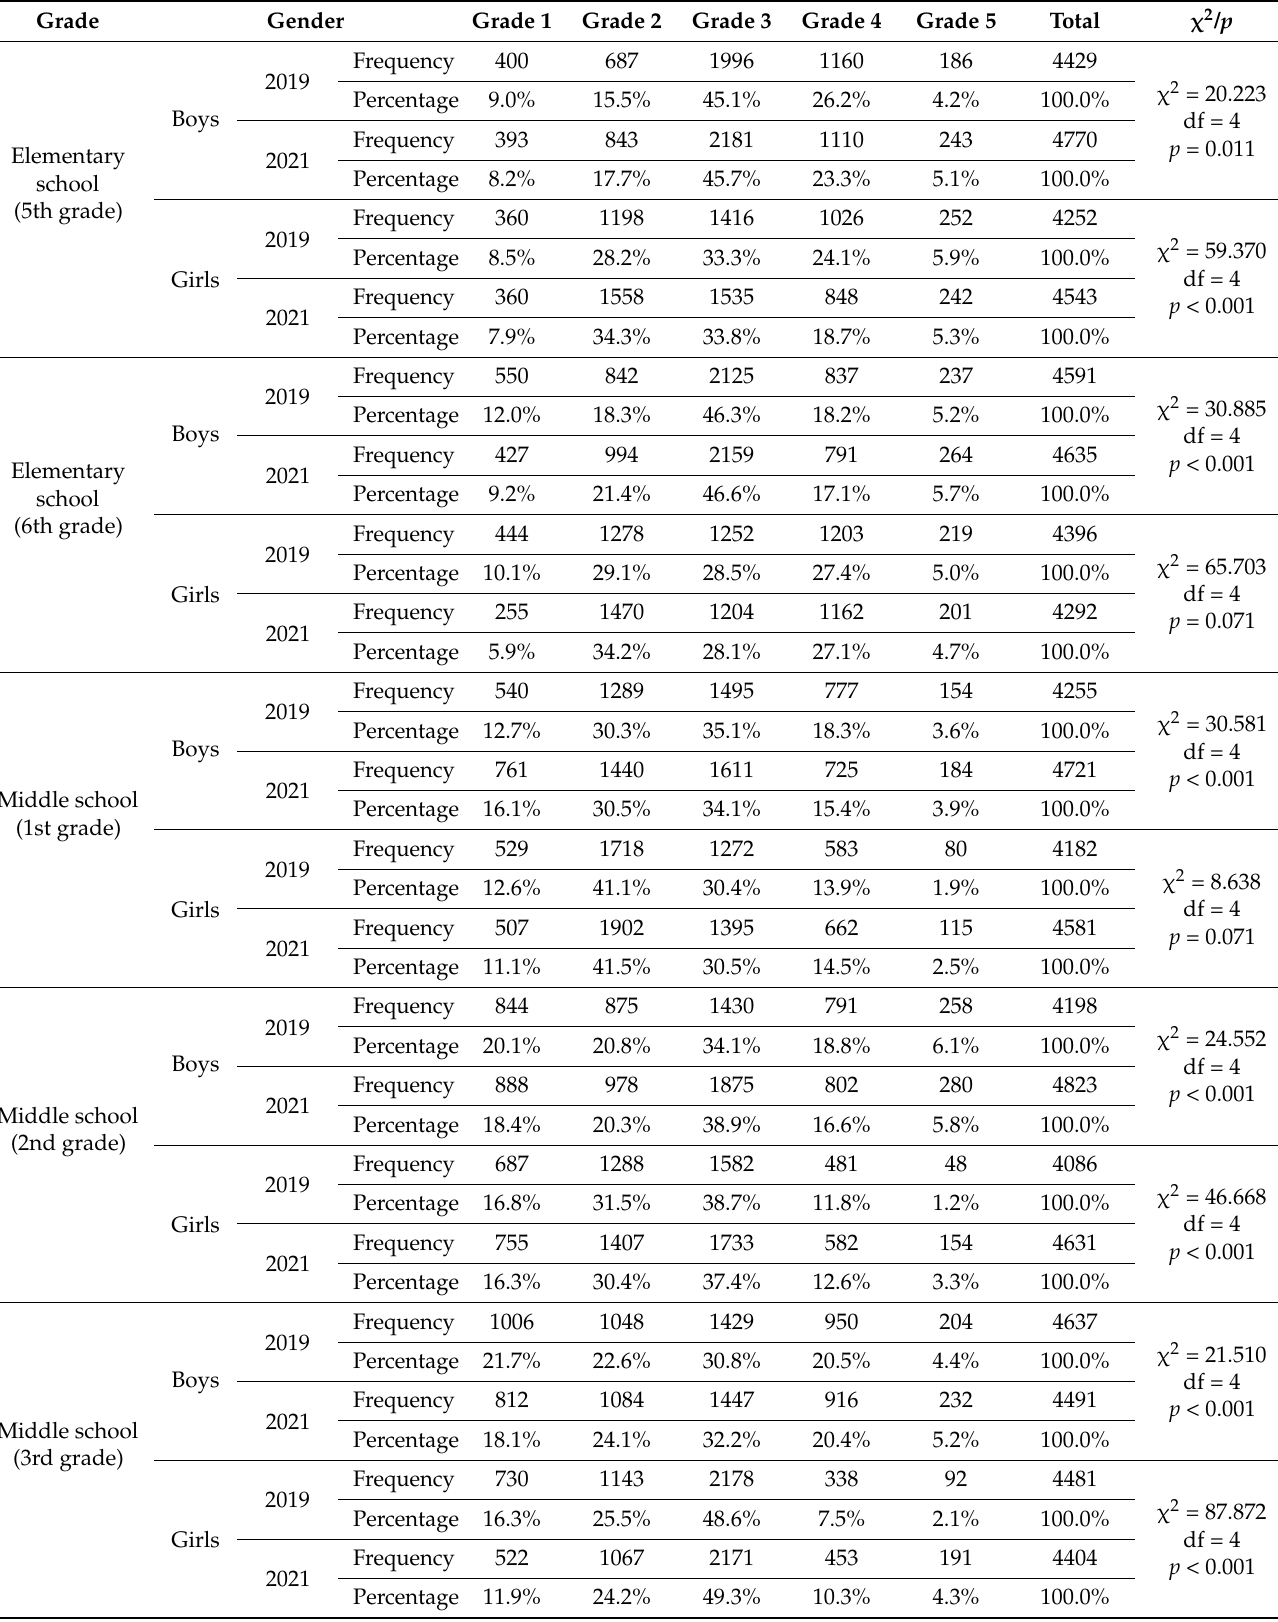
Table 5. Comparison of muscular strength in 2019 and